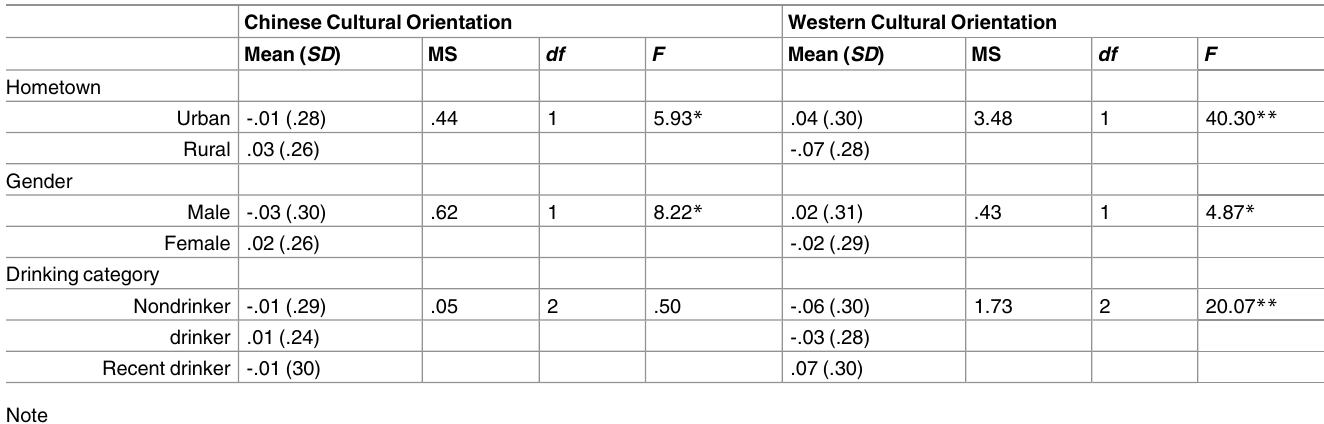
Table 1. Cultural orientation differences by hometown and